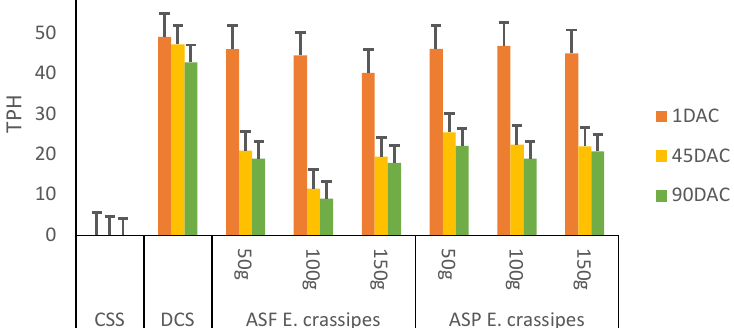
Figure 4. Change in soil TPH levels in diesel contaminated soil during bioremediation analysis Values are means with standard errors. CSS = Control Soil, DCS = Diesel oil Contaminated Soil, TPH = Total Petroleum Hydrocarbon, ASF = Amended Soil with Fresh E. crassipes , ASP = Amended Soil with Powdered E. crassipes , DAC= Days After Contamination.